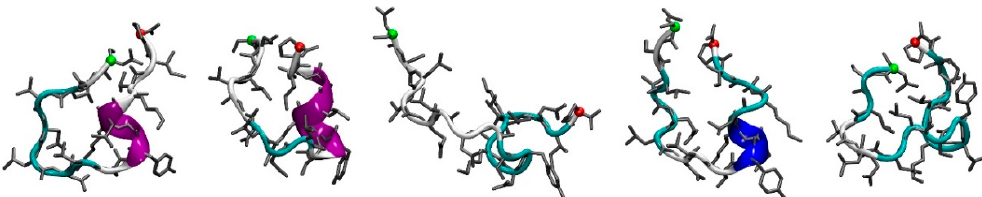
Figure 3. Representative structures of lumcorin peptides. From left to right, the first five conformations of lumcorin, extracted from MD simulations, are presented using cartoon and licorice representations. The green and red spheres represent the first and last alpha carbon of lumcorin, respectively. Table 2. Selection of the conformations for docking experiments.